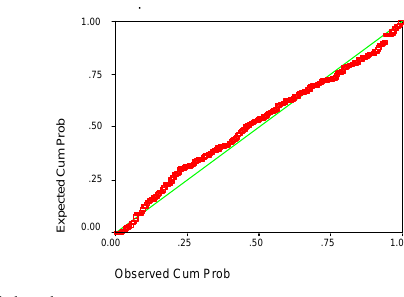
Fig. 1. The results of